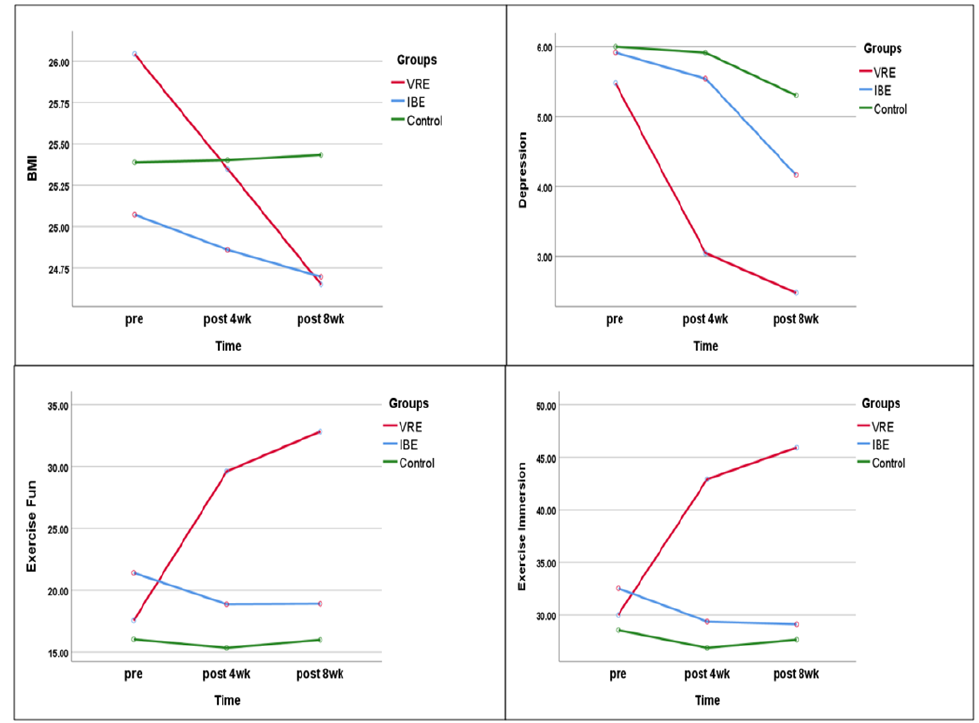
Figure 3. Comparison of BMI, depression, exercise fun, and immersion among groups.